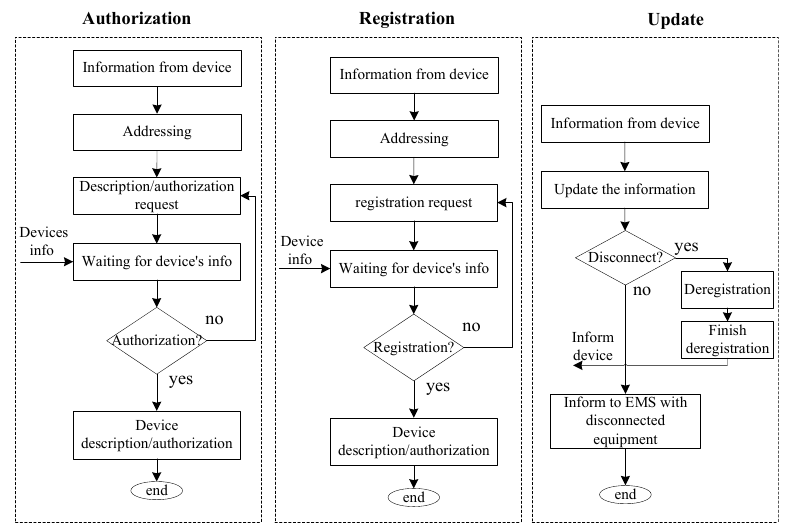
Figure 4. Flowchart of the sub-functions of auto-configuration.